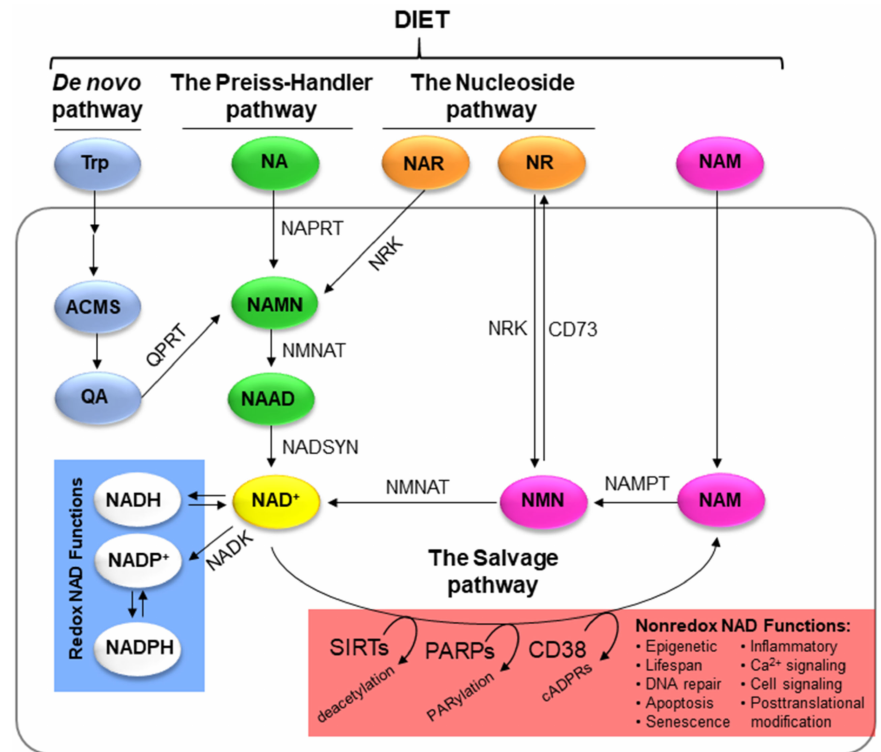
Figure 2. Different pathways in NAD+ metabolism. De novo pathway, the Preiss–Handler pathway, the salvage pathway and the nucleoside pathway are responsible for maintaining cellular NAD pools to be used in redox and non-redox